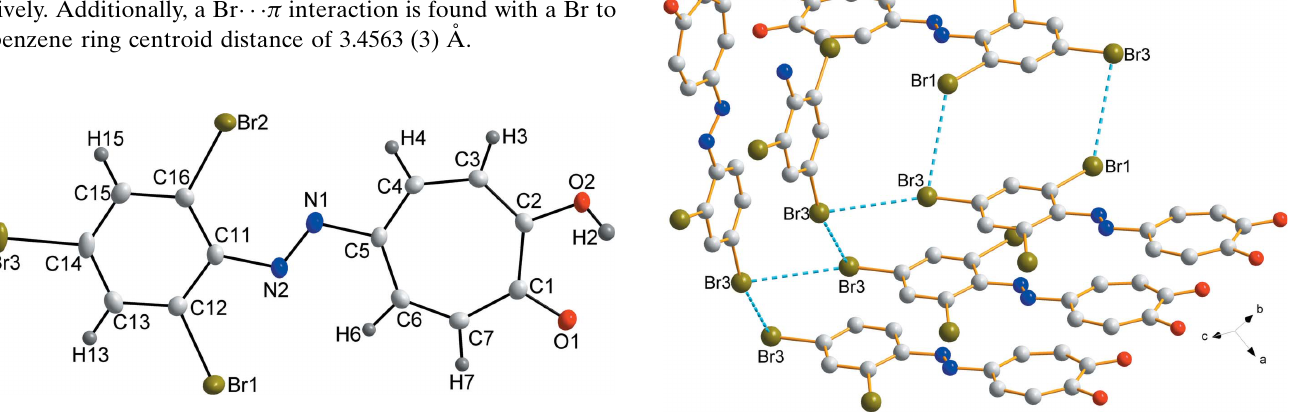
Figure 1 View of I with 50% probability displacement ellipsoids